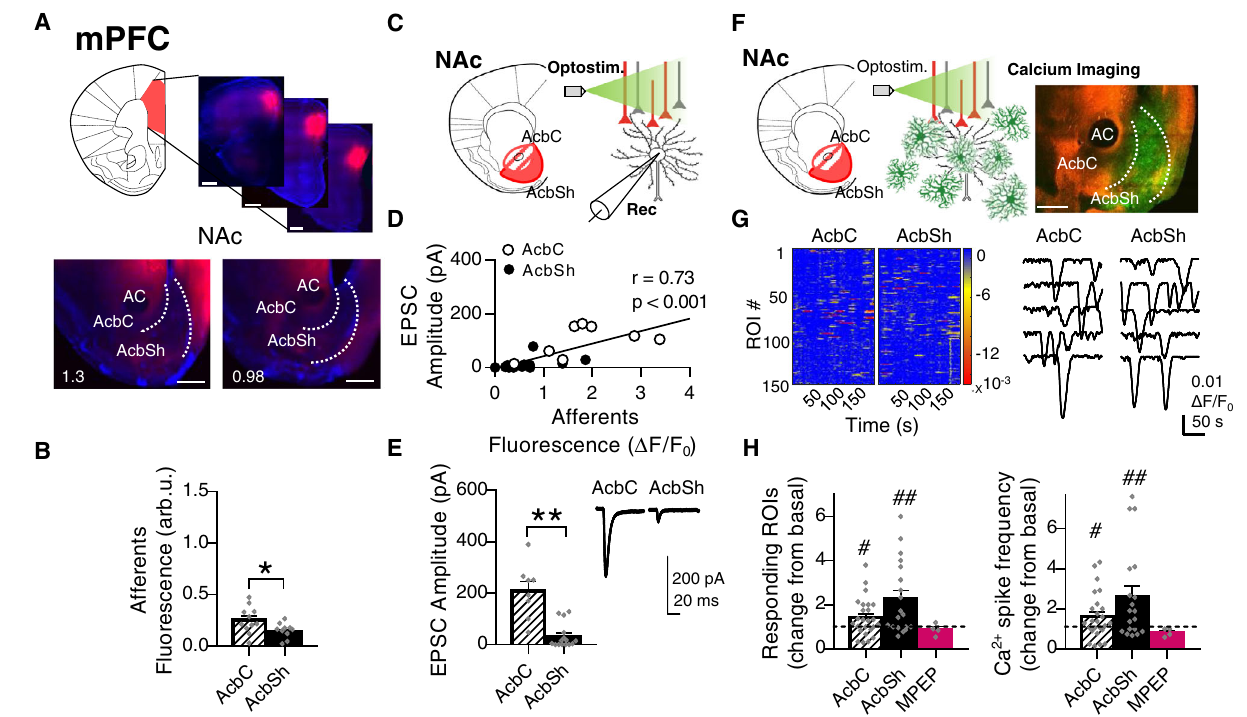
Fig. 2 | Pathway-speci fi c nucleus accumbens (NAc) astrocyte activity in response to medial prefrontal cortex (mPFC) afferents. A Scheme and repre- sentative slices showing opsin expression (ChrimsonR-tdTom) after AAV injection into the mPFC (top; scale bar = 1mm) and their tdTom-expressing afferents to the NAc(bottom;scalebar=500 µ m). B Quanti fi cationofmPFCafferents fl uorescence (arb.u.) in accumbens core (AcbC; slashed bar) and accumbens shell (AcbSh; solid bar) (11 infections, 6 mice). Two-tailed unpaired t test, * P =0.02. C Scheme of NAc neuron ’ s electrophysiological recordings in response to mPFC afferent ’ s optosti- mulation. D Positive correlation between NAc neuron ’ s response (pA) and mPFC afferents ’ density( Δ F/F 0 intheareaofregister)(20cells,3mice). E EPSCamplitude (pA) quanti fi cation (left) from AcbC (slashed bar; 8 cells, 4 mice) and AcbSh neu- rons(solidbar;15cells,4mice)andrepresentativeEPSCstraces(right)showingthe synaptic neuronal strength triggered by mPFC in each subregion. Two-tailed unpaired t test Welch-corrected; ** P =0.02. F Scheme of astrocytic Ca 2+ dynamics,